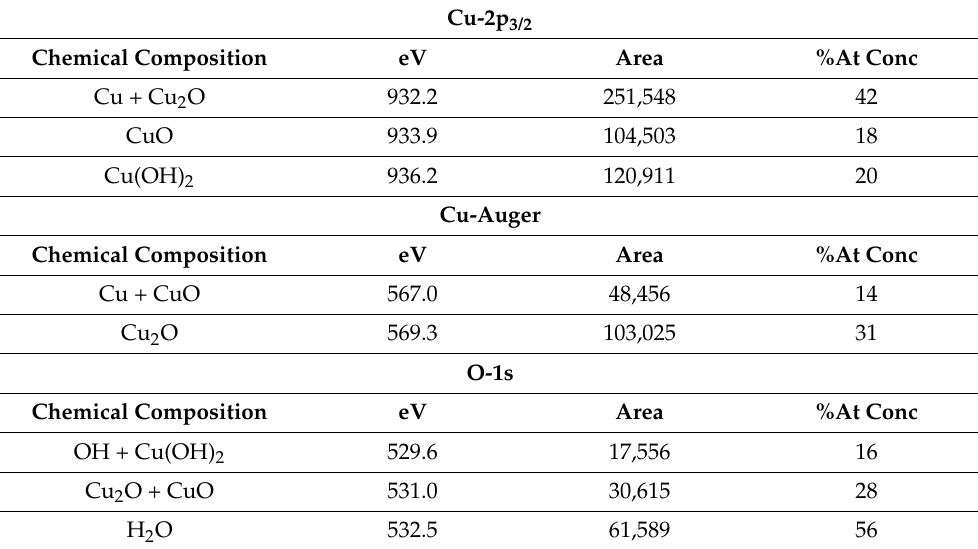
Table 1. Cu-2p and O-1s data table of XPS spectra, for Cu foils anodized at 5 °C applying a constant